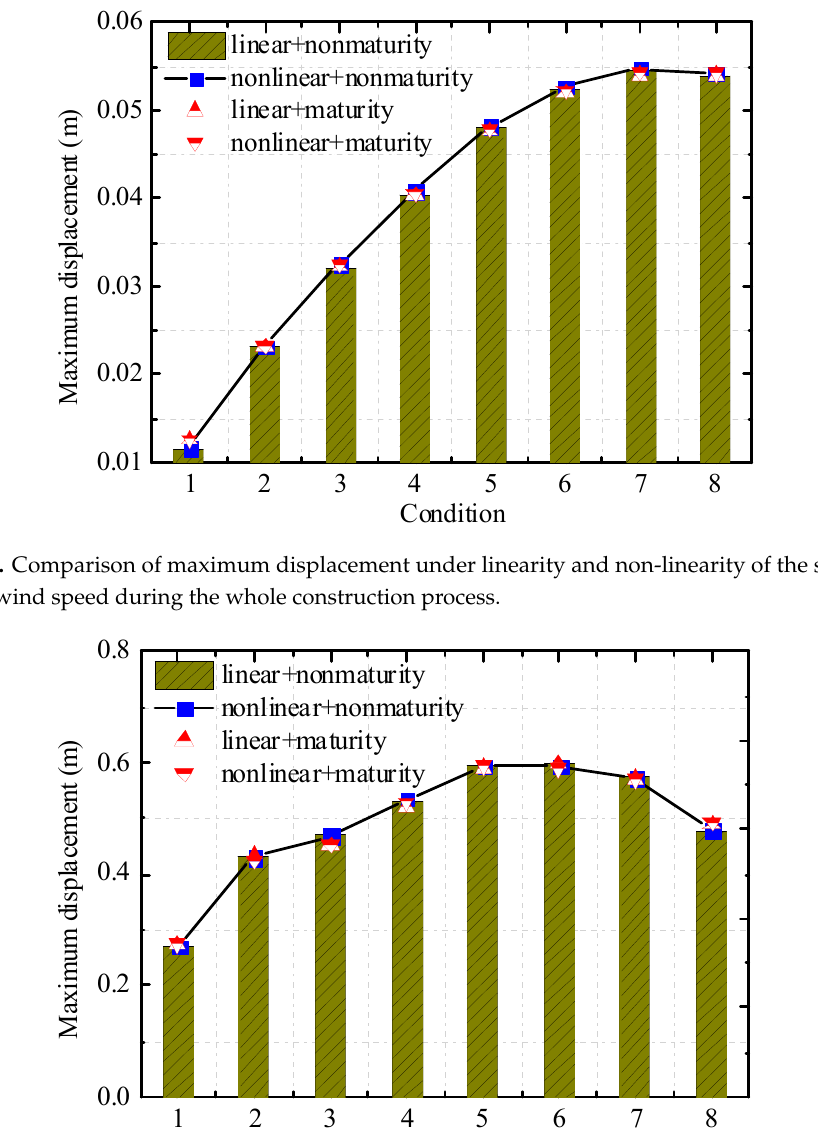
( b ) Actual wind vibration coefficient Figure 13. Changes of buckling coefficient and buckling displacement under eight working conditions. 6.2. Analysis of Geometric Non-Linearity Figure 14 and Figure 15 respectively show the typical construction conditions of cooling tower under two kinds of wind loads (actual wind-induced coefficient wind load, buckling wind speed